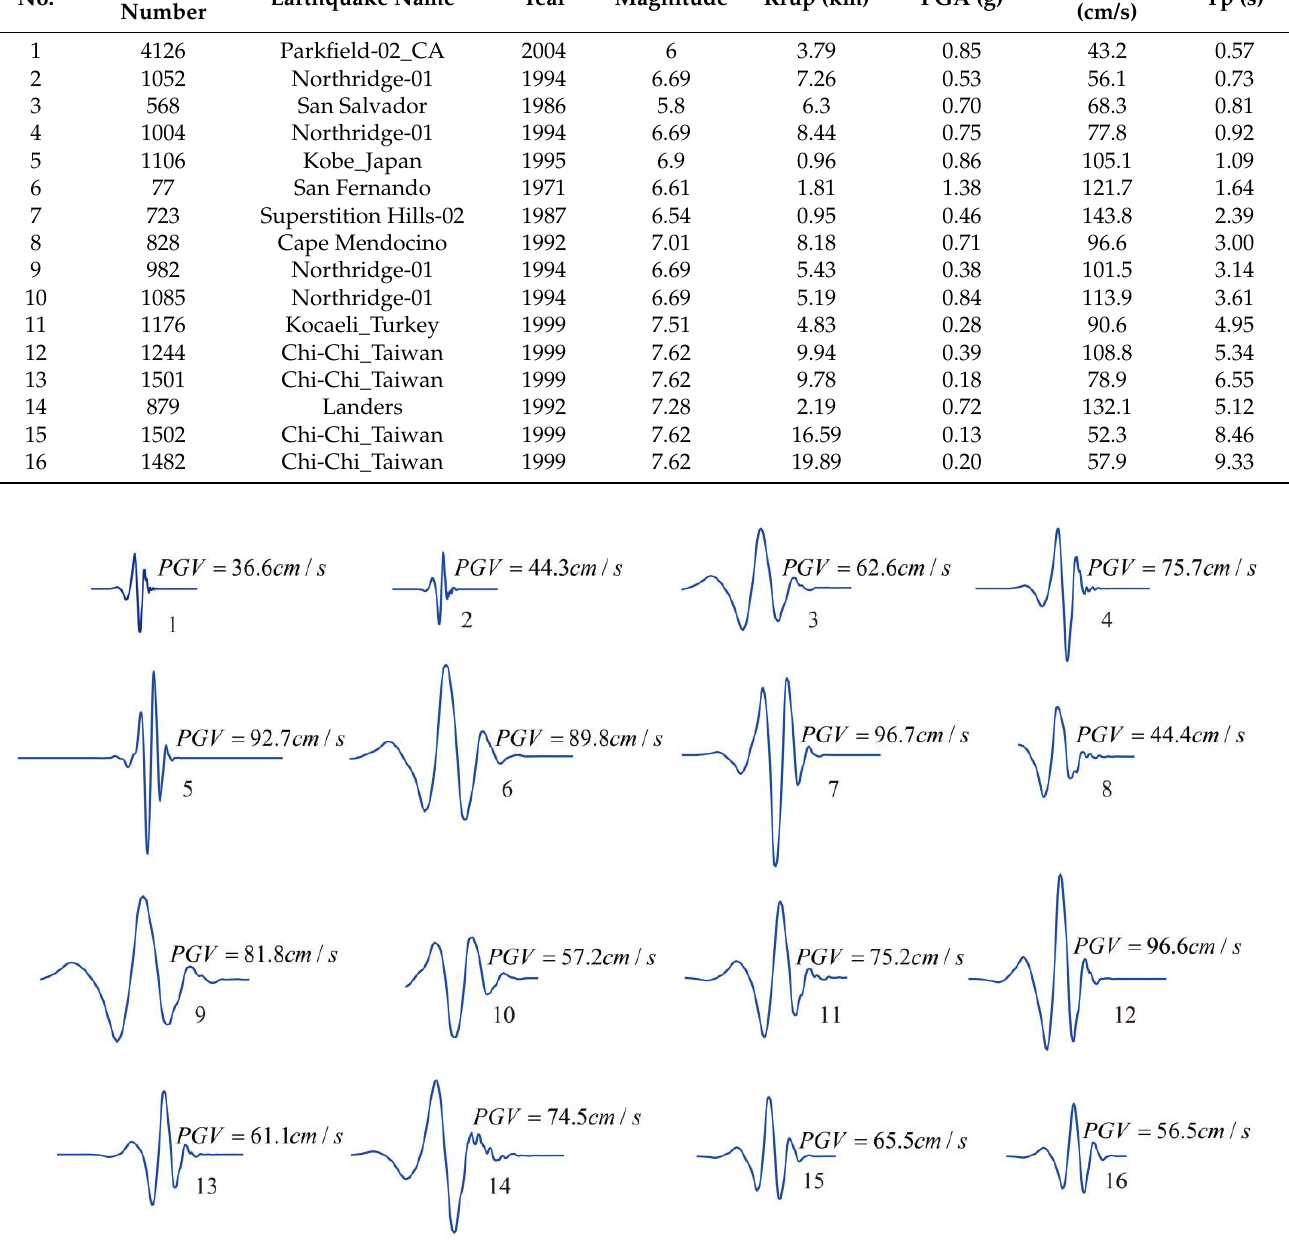
Figure 8. The strongest velocity pulses extracted from ground motions in Table 1.